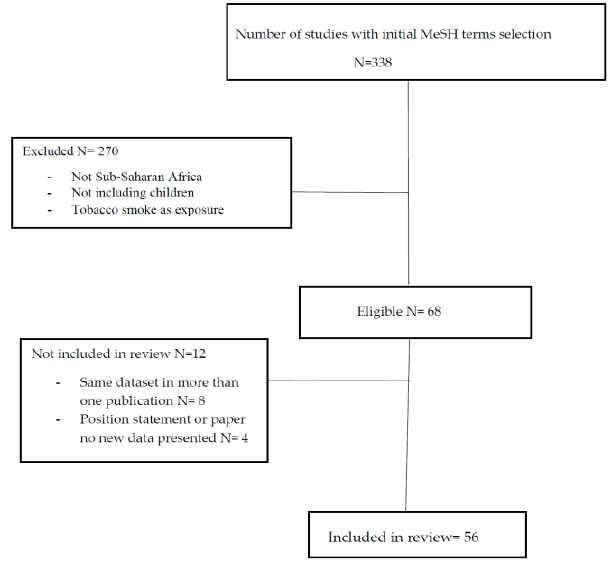
Figure 1. Studies reviewed and included on air pollution in Sub-Saharan Africa.